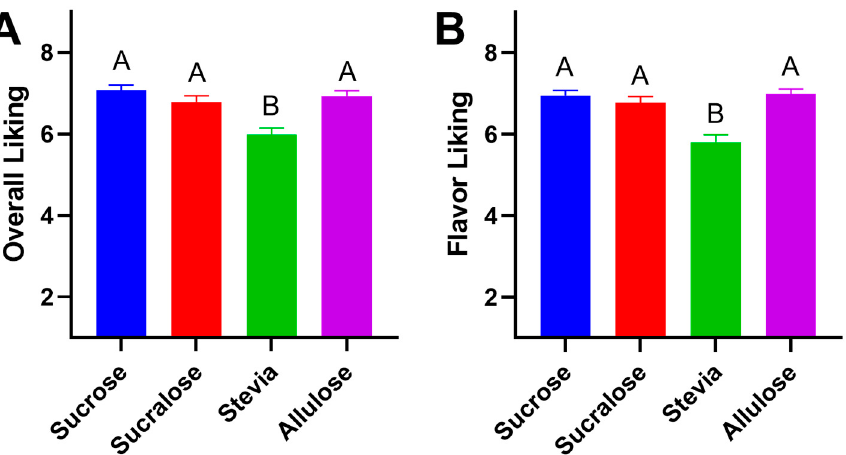
Figure 1. Overall and flavor liking of yogurt samples. 100 participants rated the 4 different yogurt samples on a 9-point hedonic scale for overall liking and flavor liking. The overall liking ( A ) data showed sucrose (7.07 ± 0.14) ranked highest, followed by allulose (6.93 ± 0.14), sucralose (6.78 ± 0.16) and stevia (5.98 ± 0.17). Compiled data for flavor liking ( B ) concluded that allulose (6.98 ± 0.13) ranked highest, followed by sucrose (6.95 ± 0.13), sucralose (6.77 ± 0.16) and stevia (5.81 ± 0.13). Bars show mean and SEM, different letters denote statistical differences.